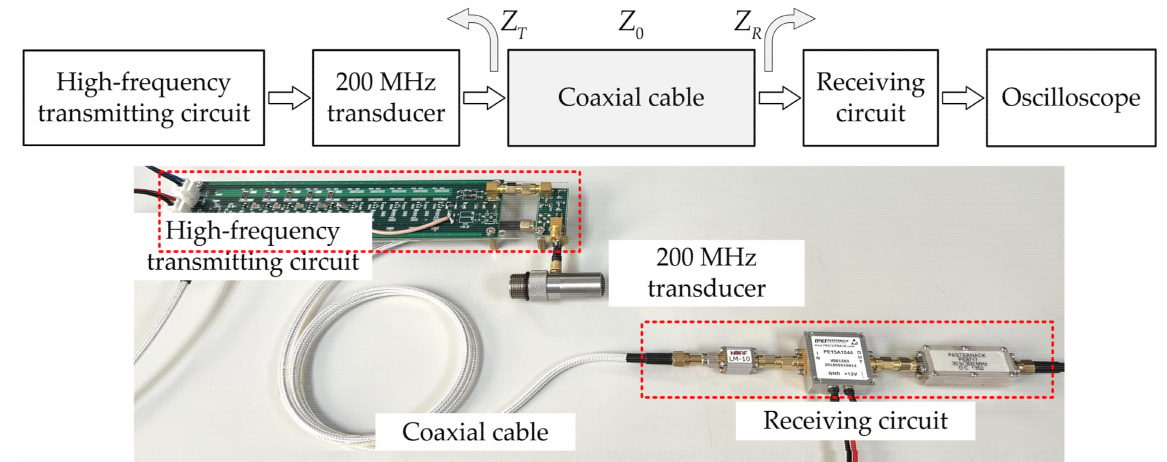
Figure 14. The 200 MHz experimental